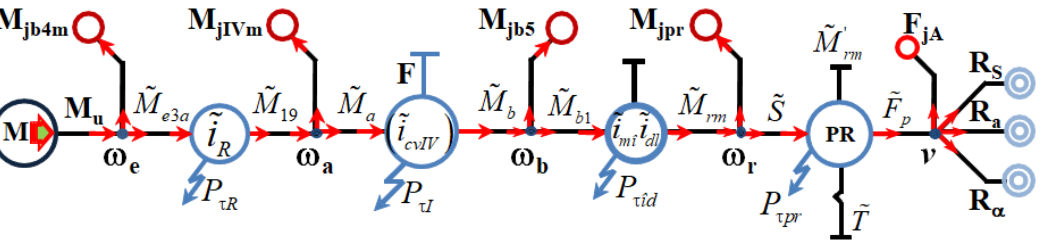
Figure 5. Generalized nodal scheme of a vehicle on tracks in the case of mechanical